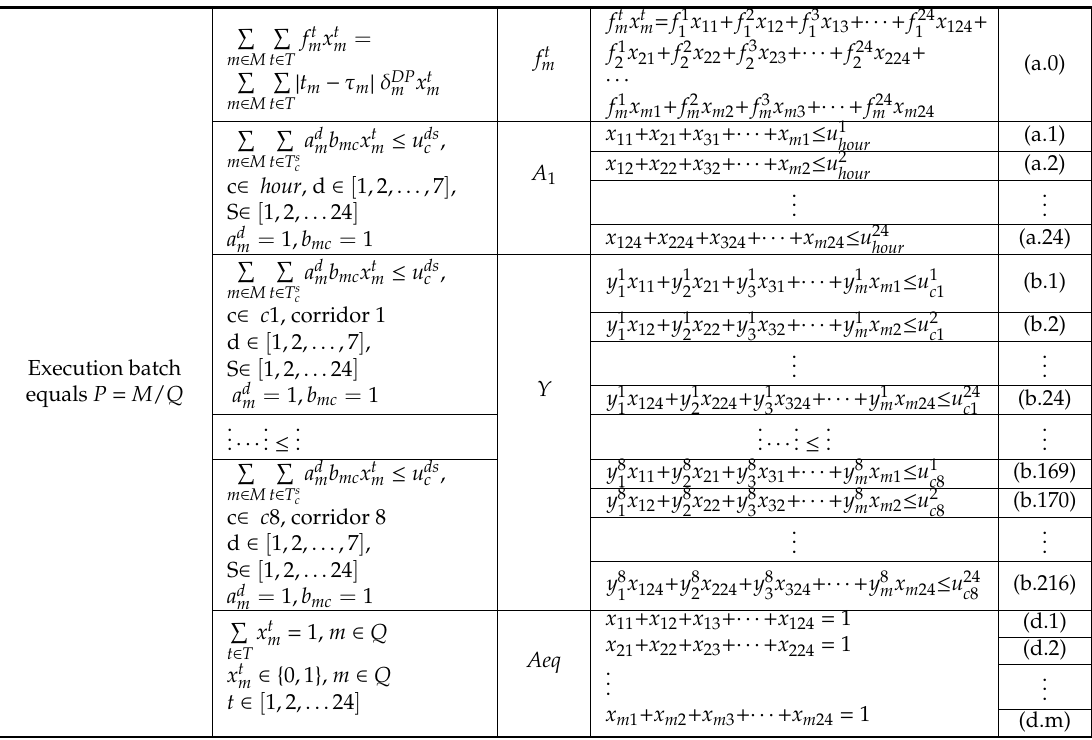
Table 3. Coe ffi cient matrix and detailed expression when interval is based on